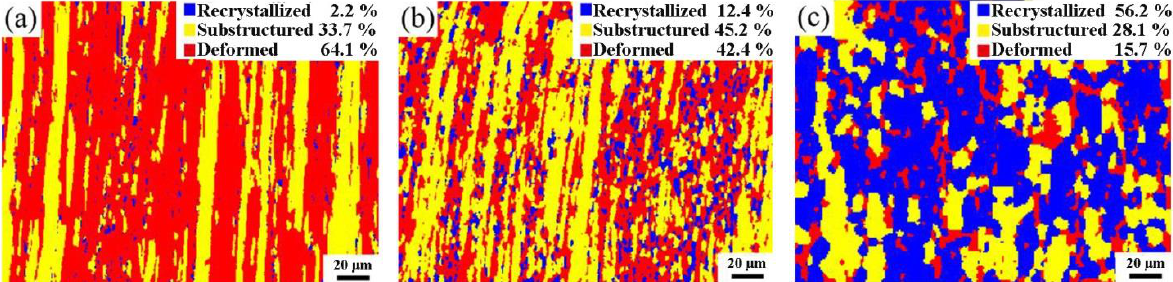
Figure 11. Distribution of recrystallized grains, sub-crystal structure and deformed structure in the EBSD maps of samples under different conditions: ( a ) 0.1 s − 1 , 573 K, ( b ) 0.1 s − 1 , 673 K, ( c ) 0.1 s − 1 , 773 K.